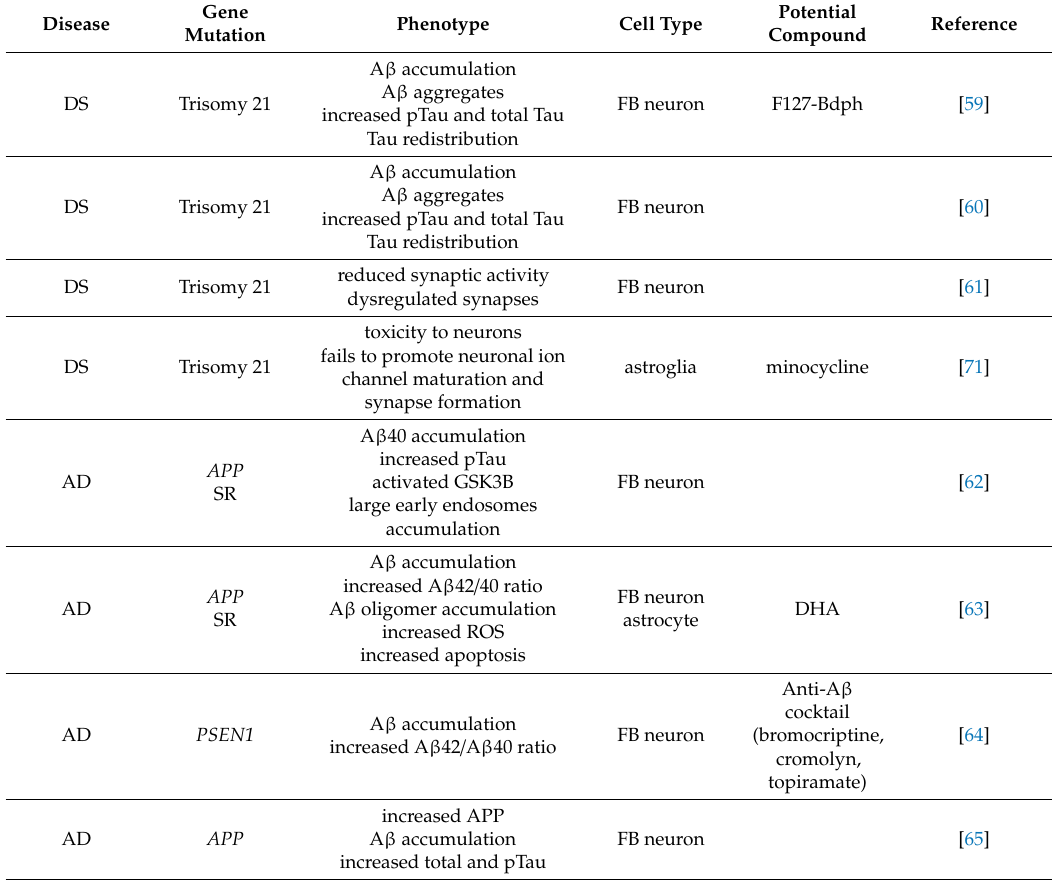
Table 1. List of publications that applied pluripotent stem cells for neurodegenerative disease modeling.